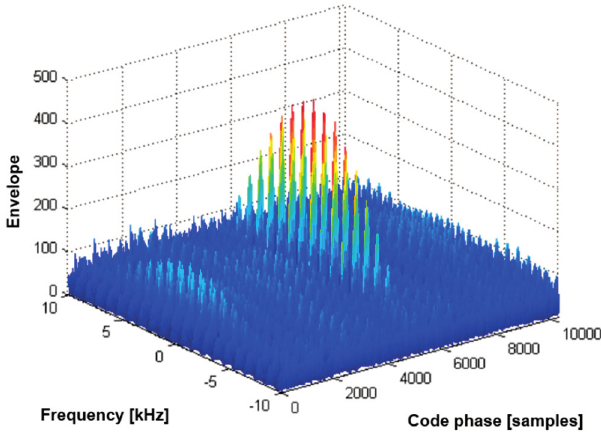
Figure 4. Side lobes due to periodic pulsed signals.